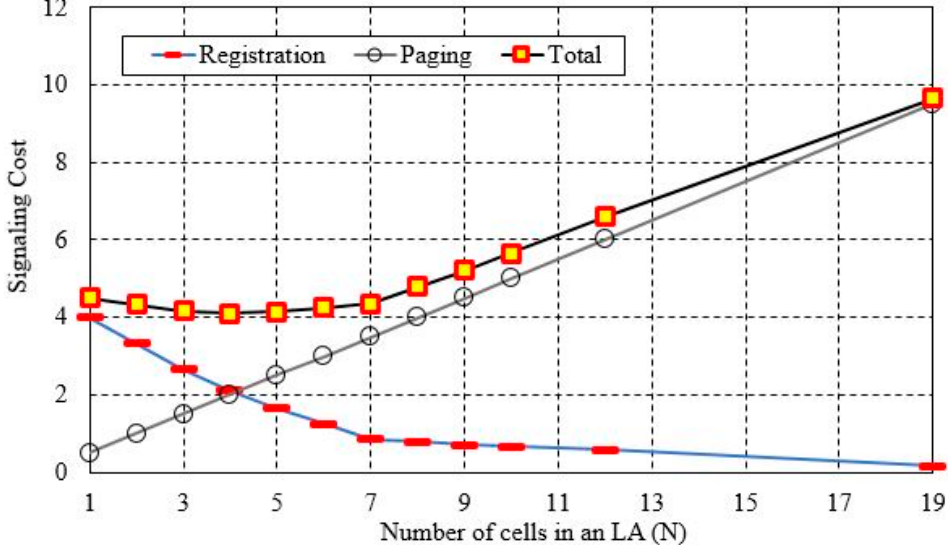
Figure 9. Total signaling cost for various numbers of cells in an LA (CMR = 1).